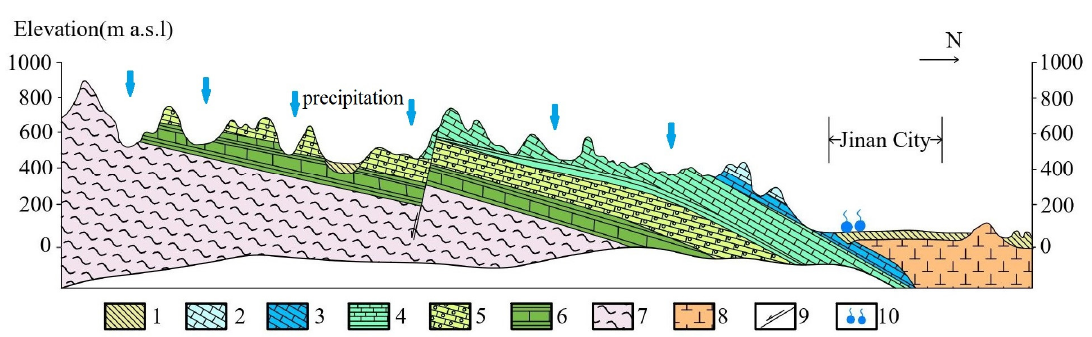
Figure 2. Hydrogeological cross-section of Jinan Spring Basin (south–north). 1 Soil (Q 4 ), 2 Limestone (O 2 ), 3 Dolomitic limestone (O 1 ), 4 Limestone and shale ( Є 3 ), 5 Oolitic limestone ( Є 3 ), 6 Limestone and shale ( Є 3 ), 7 Granitic gneiss (Ar 3 ), 8 Diorite (Mz), 9 Fault, 10 Springs.